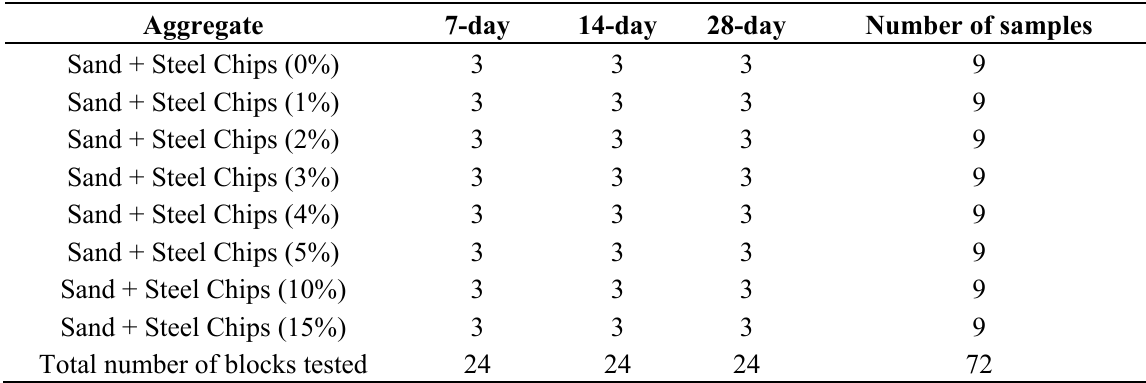
Table 1. Number of blocks at the various testing